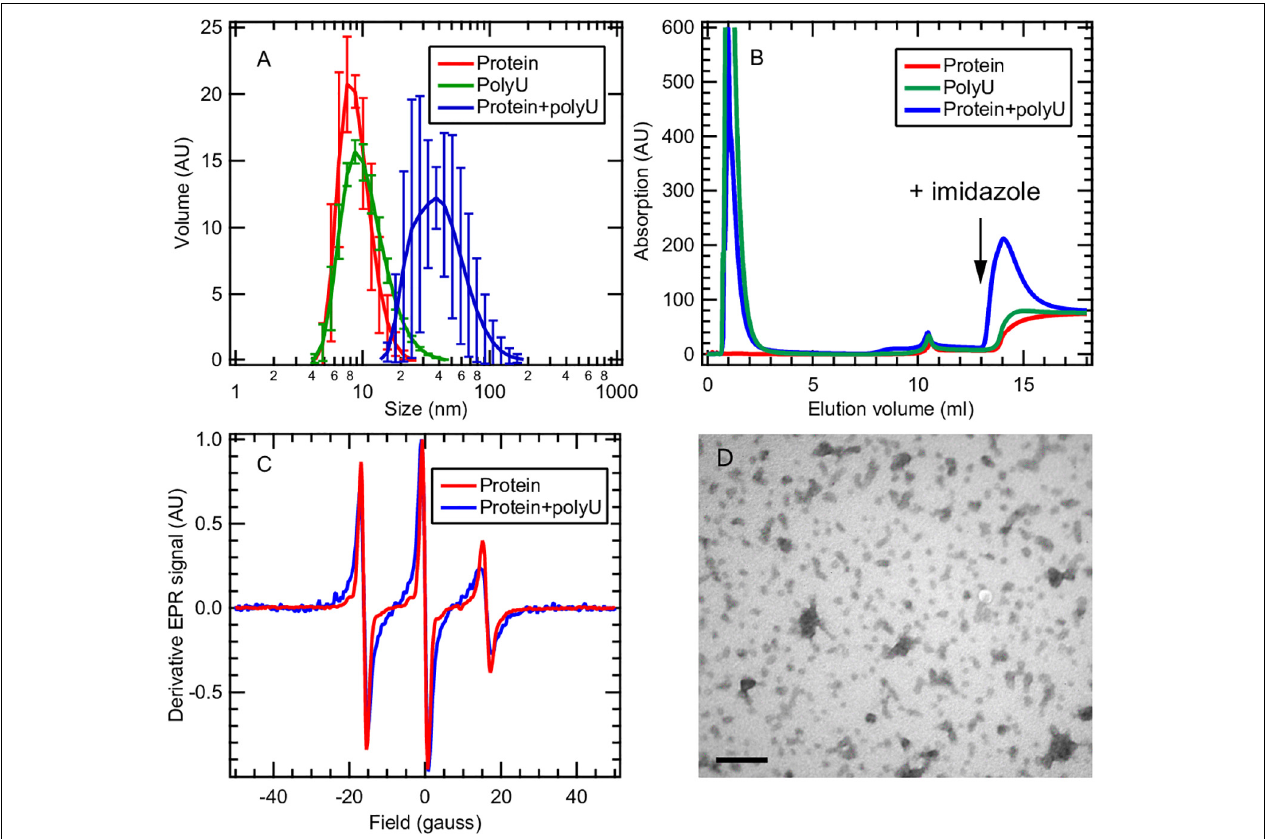
FIGURE 6 | Tau187 and polyU form a complex. (A) tau187 (100 µ M) incubated with polyU (1 mg/mL) (blue) exhibit a larger hydrodynamic radius than tau187 alone (red) or polyU alone (green), as shown by DLS. Error bars represent standard deviation over 3 independant repeats, each composed of 3 measurements of the same sample. (B) tau187, which possesses a histidine tag, can be immobilized onto a Ni-affinity column (mounted on a FPLC system), and eluted by imidazole. The absorption value reports on the presence of polyU, which has an absorption coefficient 100 times larger than that of tau187. The fact that RNA is eluted